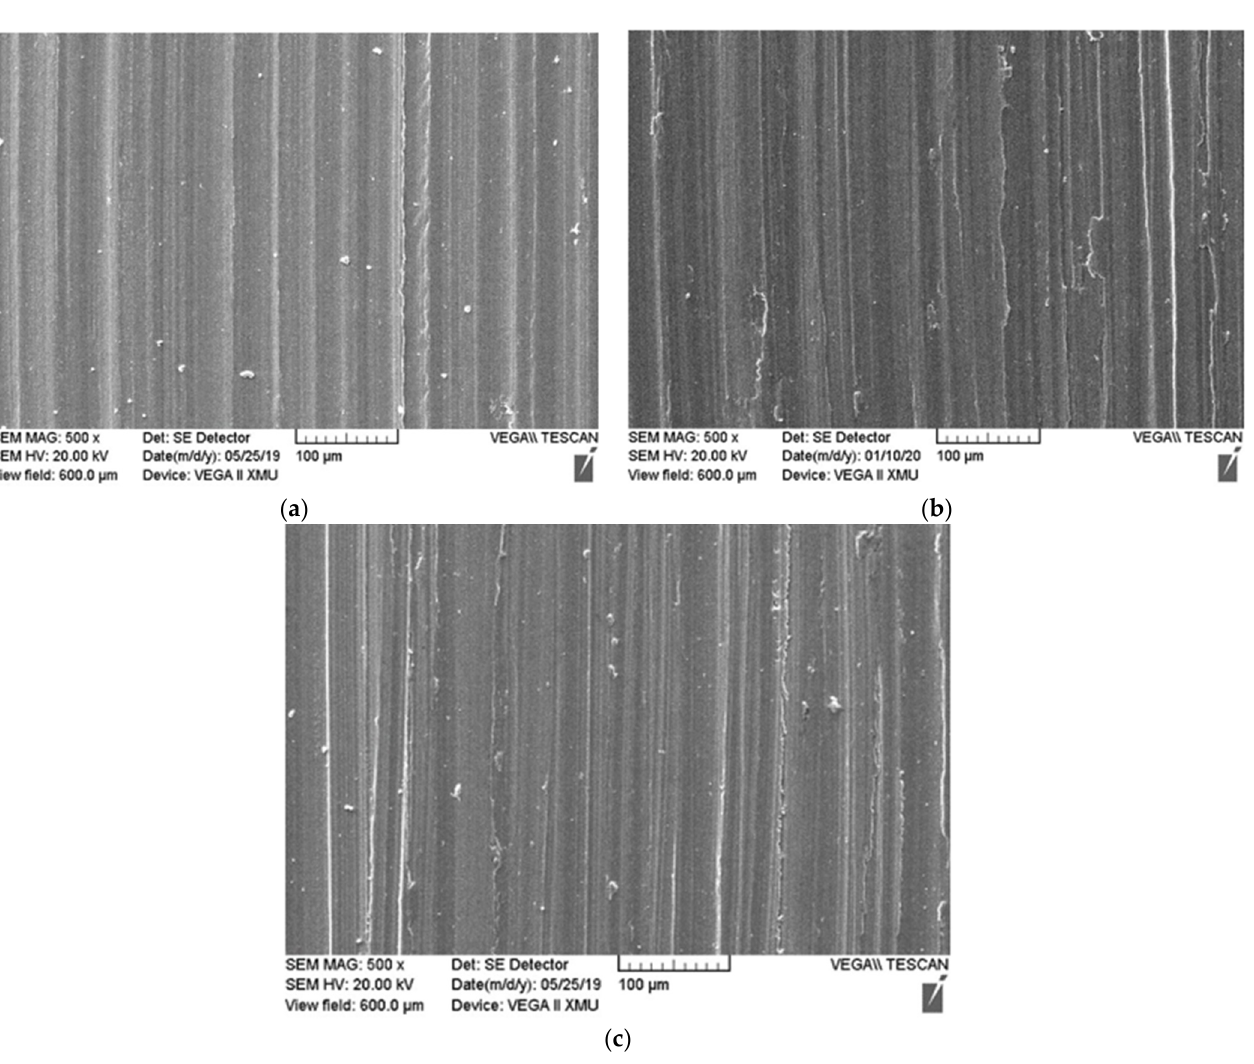
Figure 11. The morphologies of worn surface for TC4 against 11 Si 3 N 4 /Mo pin sample in artificial seawater under different loads: ( a ) 10 N; ( b ) 20 N and ( c ) 30 N.